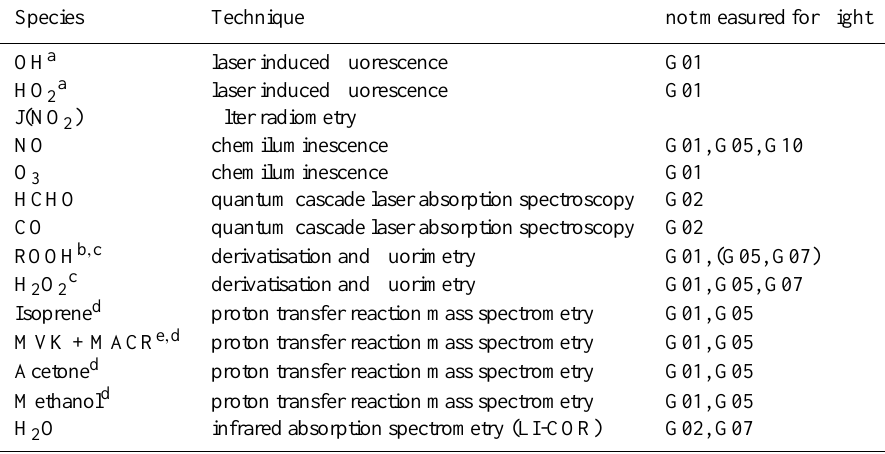
Table 2. Overview of the species observed and measurement techniques used during the GABRIEL campaign. Species Technique not measured for flight OH a laser induced fluorescence G01